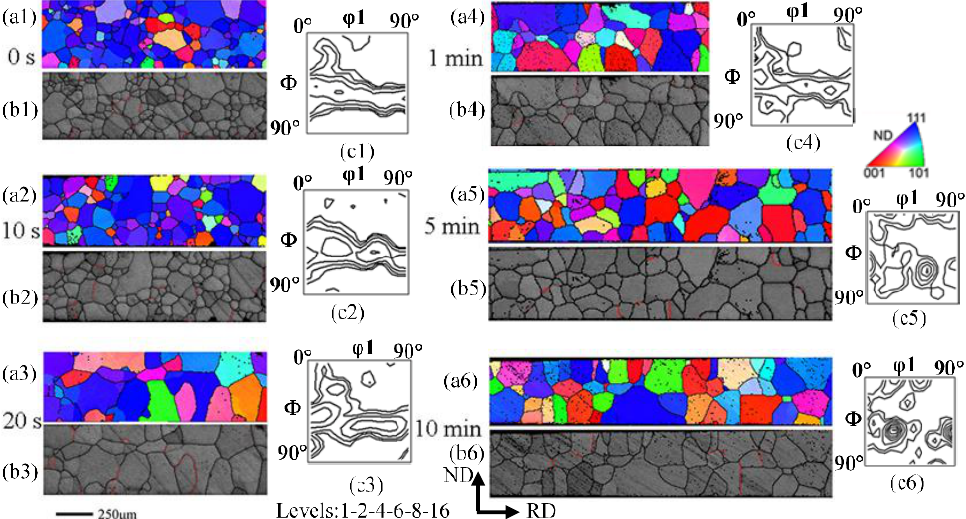
Figure 6. The microstructure and texture evolution during transformation treatment in 2# sheets at different holding times. Starting from hot-rolled sheets, cold rolling to 0.5 mm with 80% reduction. Heating to 1050 °C for different time and cooled either by water quenching ( a1 – a3 ) or 5 °C/min in H 2 of 4 L/min ( a4 – a6 ). ( a1 – a6 ) IPF-ND maps, ( b1 – b6 ) band contrast maps (red lines: Σ 3 boundary)